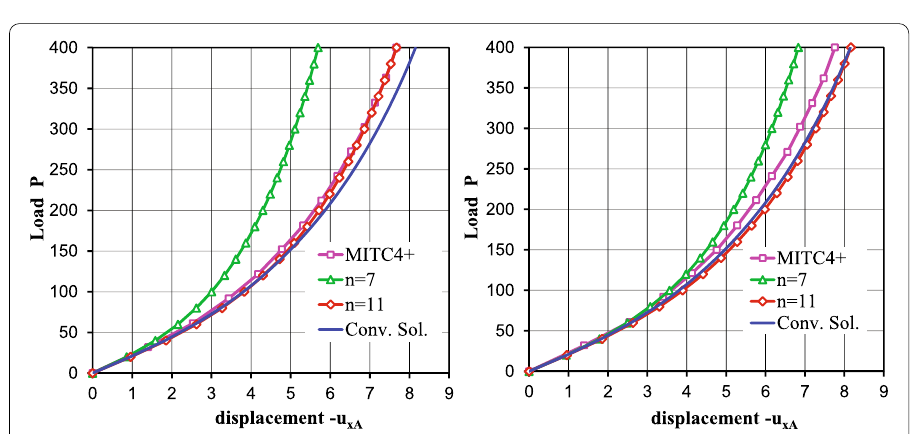
Fig. 7 Hemispherical shell: P − u xA for the regular 8 × 8 (left) and 12 × 12 (right) meshes